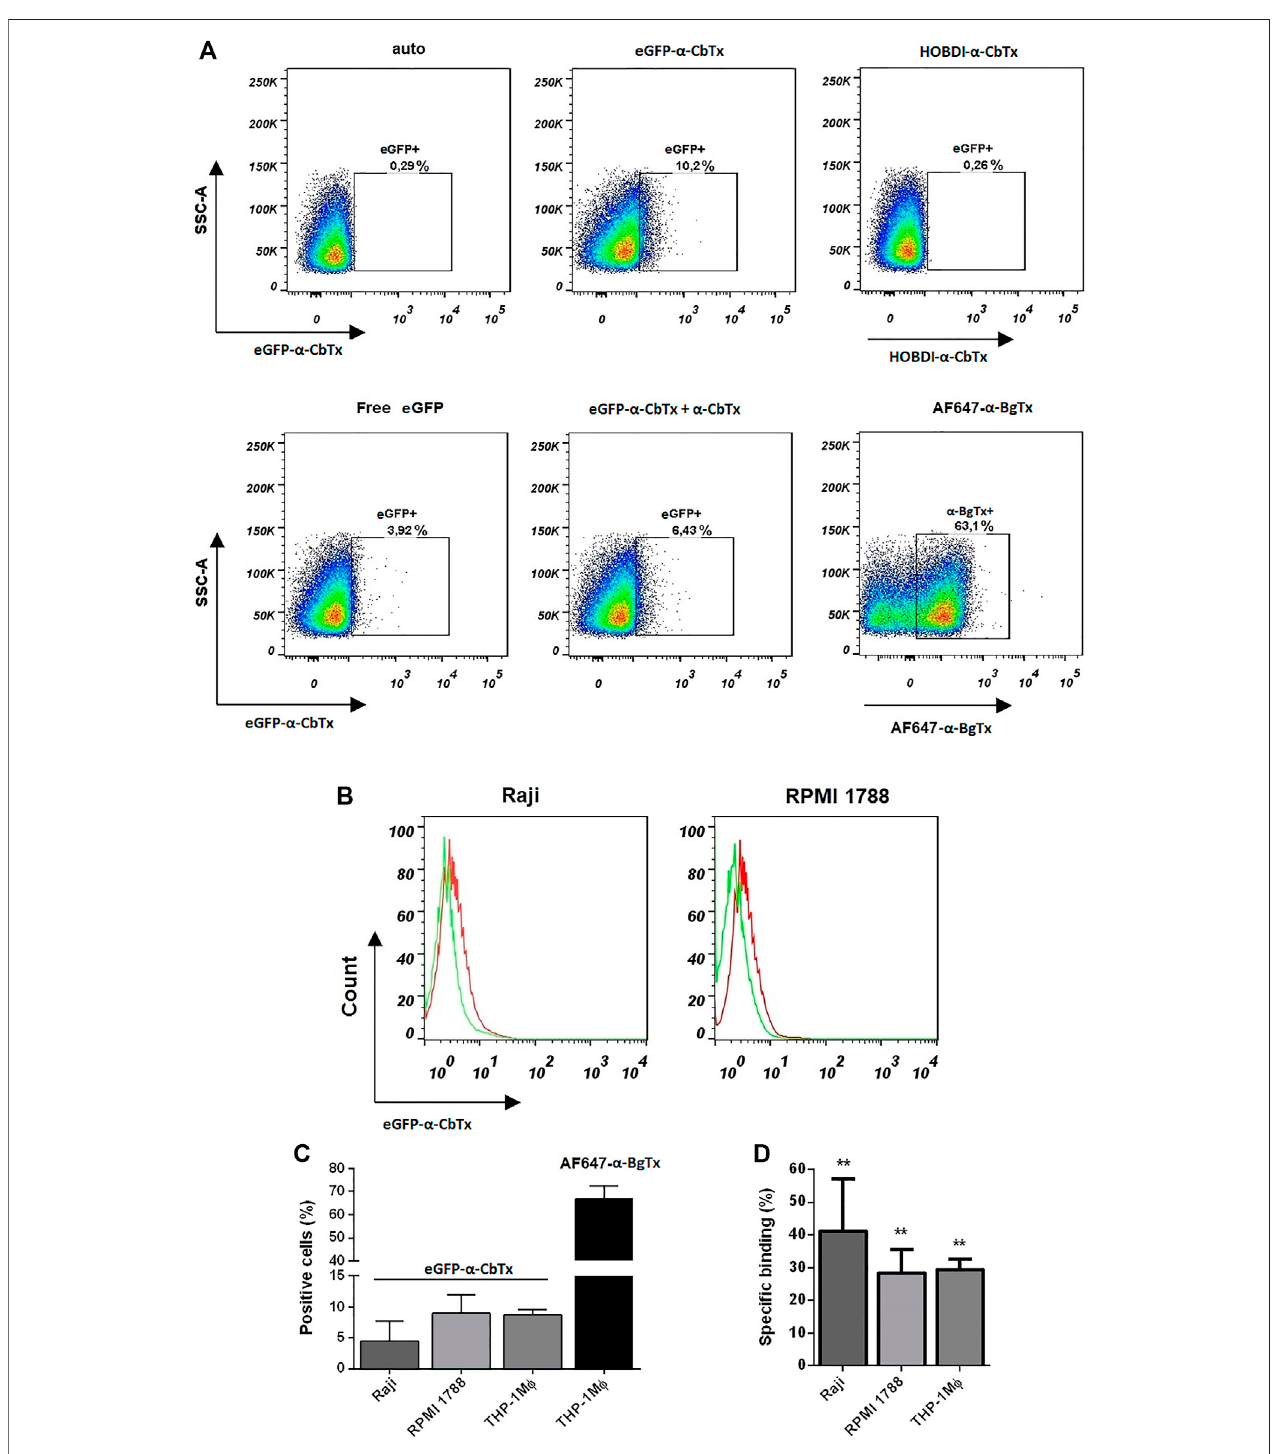
FIGURE 7 | Investigation of cell binding and staining using fl uorescent α -CbTx analogs by fl ow cytometry. (A) Representative dot plots of stained THP-1 M ϕ cells using two fl uorescent toxins, i.e. eGFP – α -CbTx and HOBDI-BF 2 – α -CbTx. In the top row the auto fl uorescence, cells stained with eGFP – α -CbTx and HOBDI-BF 2 – α - CbTx, are shown. In the bottom row cells stained with free eGFP, eGFP – α -CbTx with excess of α -CbTx and cells stained with AF647 – α -BgTx as a control, are shown. Regions in dot plots represent the percentage of stained cells. (B) Representative histograms of Raji or RPMI 1788 cells stained with eGFP – α -CbTx. Red histogram, cellsstained witheGFP – α -CbTx; green histogram, cellspre-incubated withanexcess offree α -CbTxand then stainedwitheGFP – α -CbTx.Adecrease inthe fl uorescenceofcellsduetothebindingoffree α -CbTxisrevealed. (C) Diagramsshowingthenumberofpositivecells(Raji,RPMI1788,andTHP-1M ϕ )whenstainedwith eGFP – α -CbTx or AF647 – α -BgTx. (D) Diagrams of speci fi c binding (%) of eGFP – α -CbTx on different cells from three independent experiments (mean ± S.E.M.)). One- way ANOVA tests with Tukey post hoc test (**p < 0.01) were used.